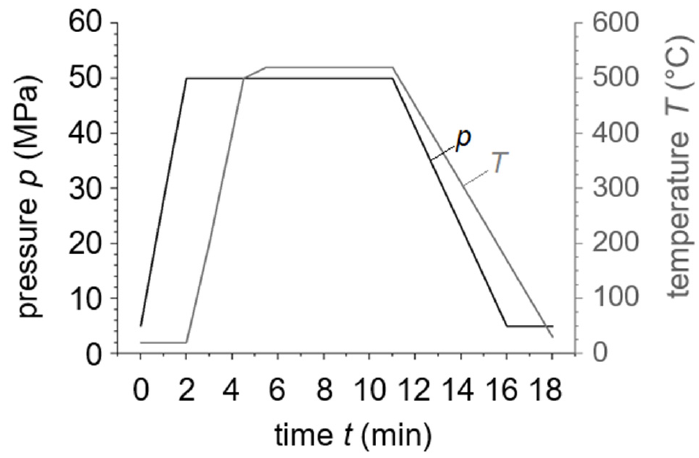
Figure 2. Pressure and temperature during sample production by the FAST sintering process. Powder was consolidated at 520 °C for 5 min at a pressure of 50 MPa. Before holding time, the heat rate was lowered to prevent a temperature overshoot.